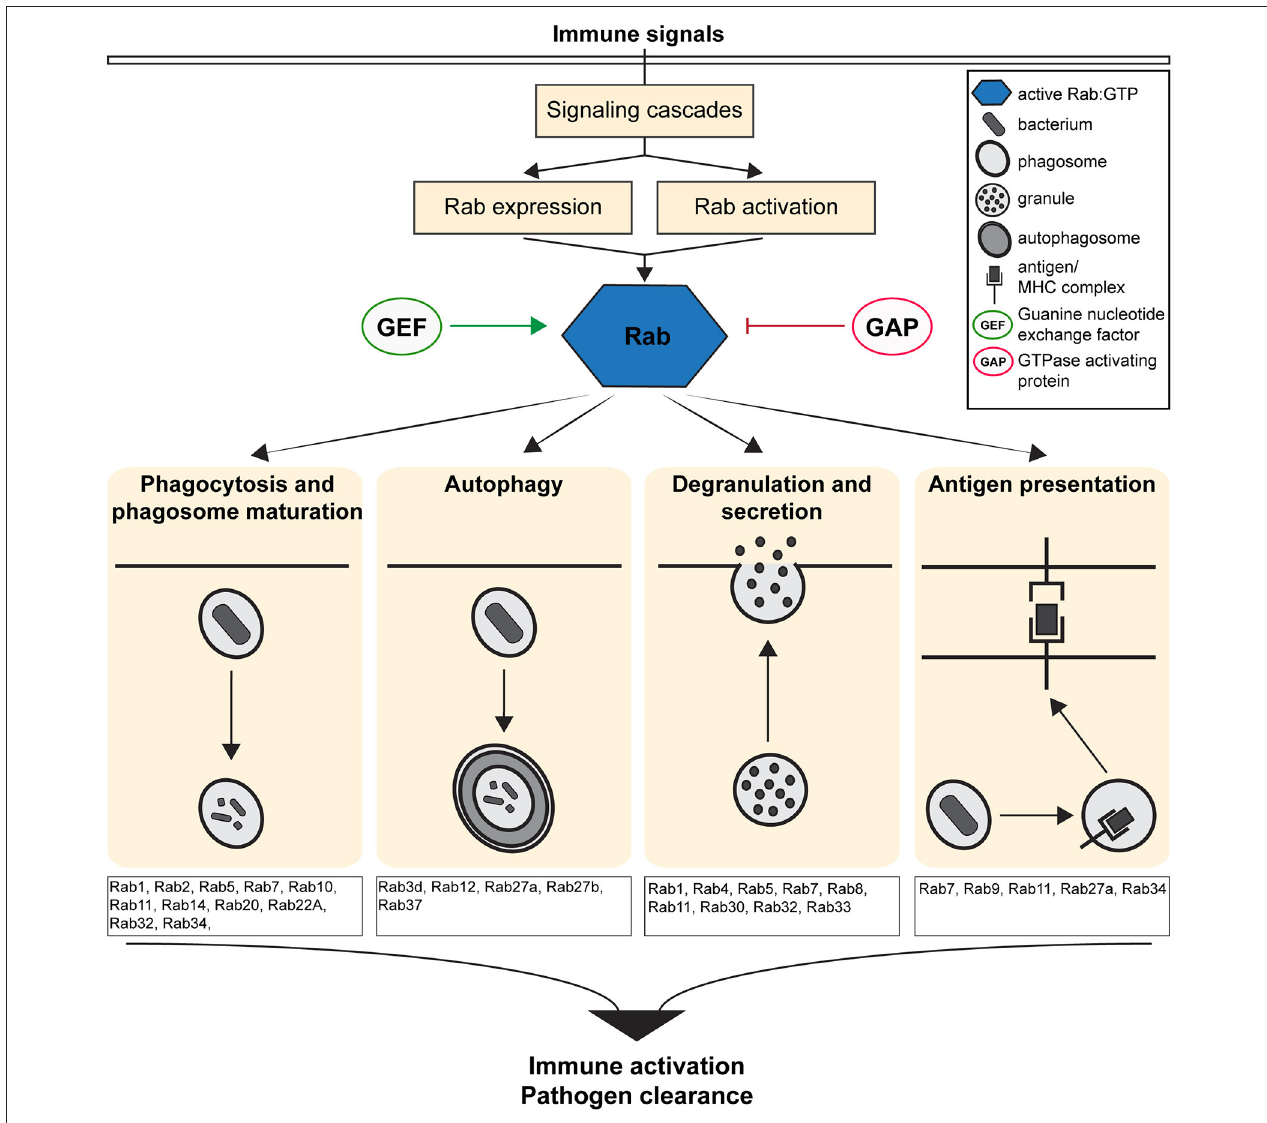
FIGURE 1 | Overview of the Immune defense pathways regulated by the activity of Rab GTPases. Figure shows the cellular and molecular mechanisms by which Rab GTPases regulate immunity and inflammation by controlling the formation, transport and fusion of intracellular organelles.